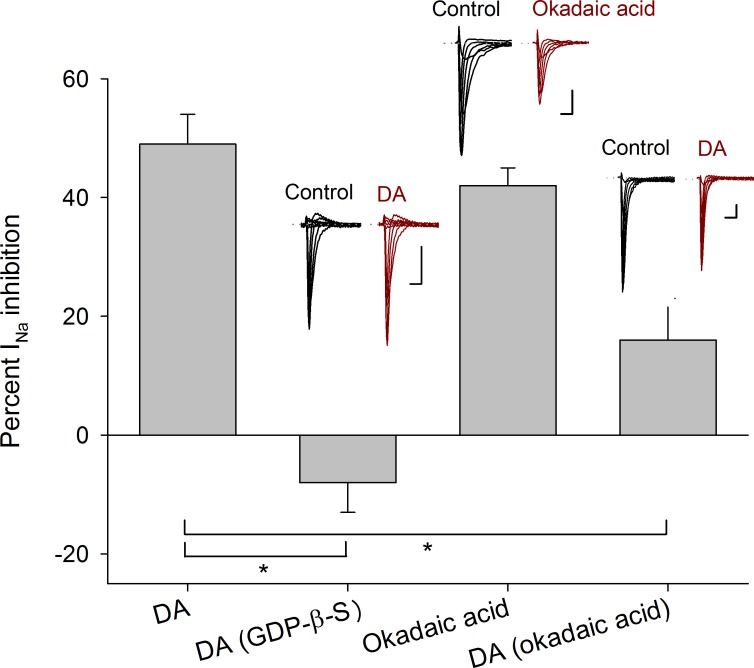
Intracellular mechanism inherent to D1- and D2-like receptors.Bars indicate the percent INa inhibition produced by 100 μM DA and compared with its effect when 500 μM GDP-β-S (P < 0.001) were added intracellularly. The perfusion of 100 nM okadaic acid decreased the INa amplitude in a similar percentage as 100 μM DA (P = 0.3 unpaired t-test). While 100 nM okadaic acid added intracellularly occluded the DA action (P = 0.01). Insets above bars show representative recordings in control conditions and after drug application. Asterisks denote a significant difference (P < 0.05 unpaired t-test). Calibration bars are 1 ms and 0.5 nA for all recordings.